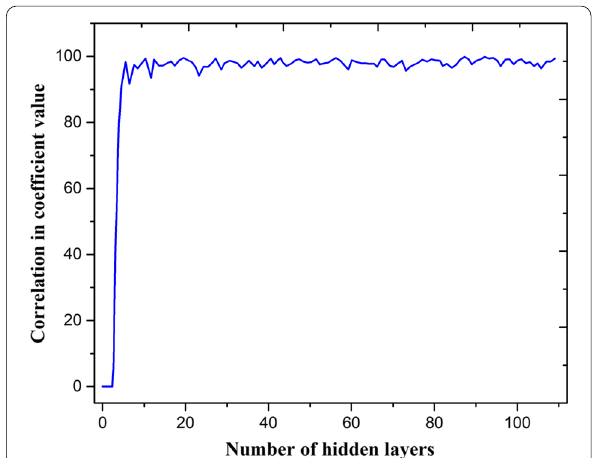
Fig. 3 Hidden layer selection using correlation